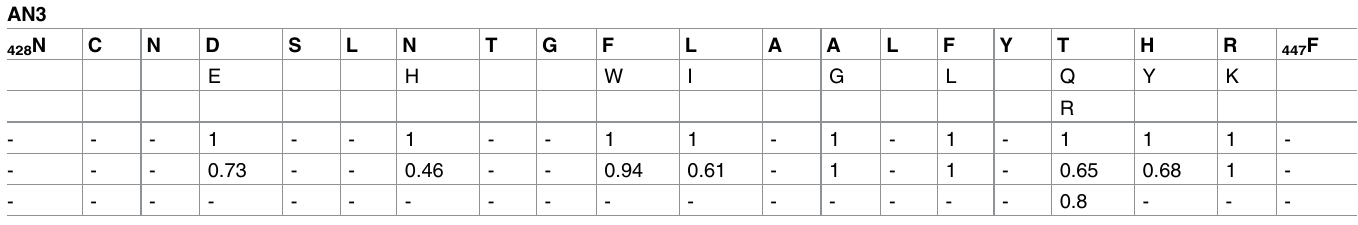
Data presented is analysed and predicted using programme SIFT (http://sift.jcvi.org/www/SIFT_aligned_seqs_submit.html). Row corresponds to a position in the reference epitope. Column corresponds to amino acid variation (observed in our data set) at that position in different HCVpp (Fig 4A). Score at a particular position for an amino acid substitution is mentioned below the amino acid variant. The default threshold for functional intolerance used was 0.05 for amino acid substitution.